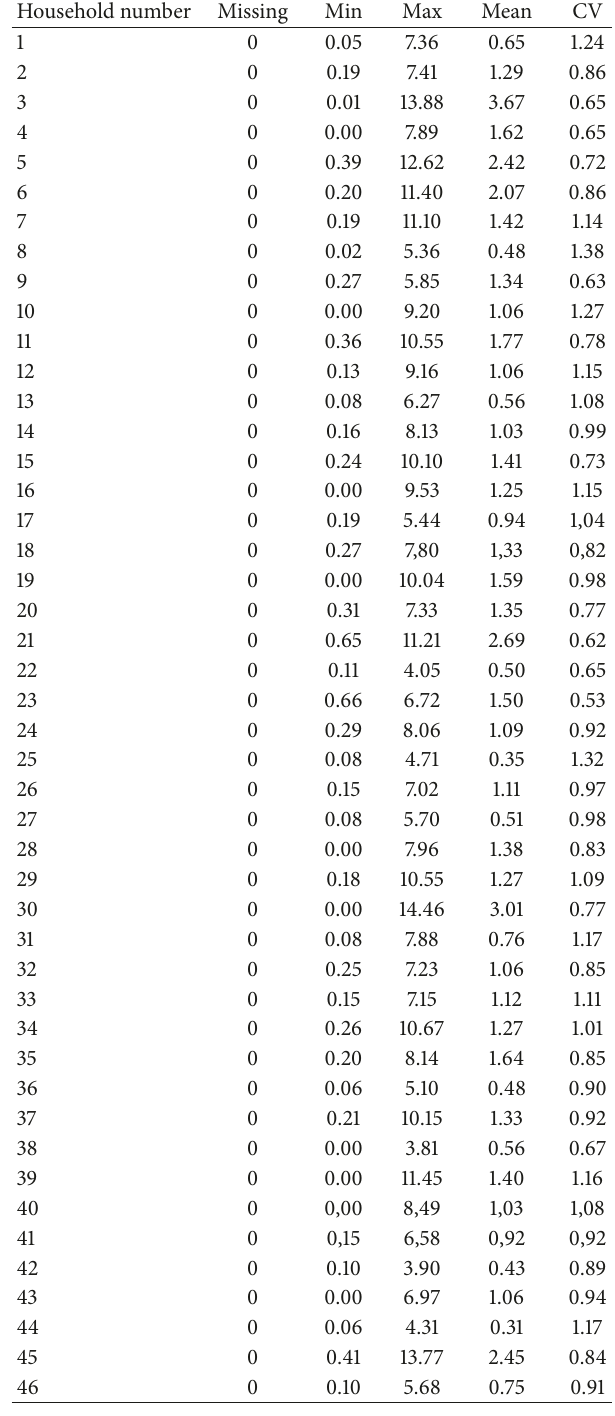
Table 1: Descriptive statistics for the electric load observed at each of the